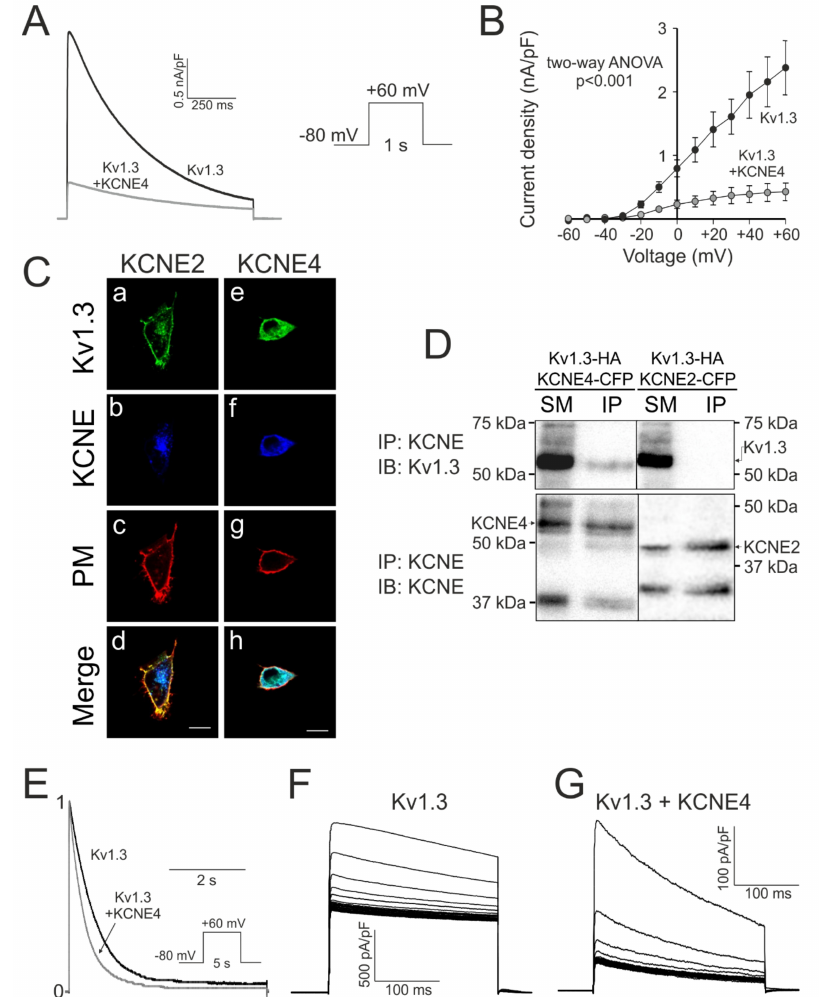
Figure 2. KCNE4 specifically modulates Kv1.3. HEK-293 cells were transfected with Kv1.3-YFP in the presence ( + KCNE4) or the absence of KCNE4-CFP. Cells were held at − 80 mV, and currents were elicited by 1 s depolarizing pulses from − 60 mV to + 60 mV in 10 mV intervals. ( A ) Representative traces at + 60 mV. ( B ) Current density vs. the voltage of K + currents ( p < 0.001 vs. + KCNE4, two-way ANOVA; n = 3–5). Values are the means ± SE. Black symbols, Kv1.3; gray symbols, Kv1.3 + KCNE4. ( C ) Confocal images of HEK-293 cells cotransfected with Kv1.3-YFP and KCNE2-CFP (Ca-Cd) and KCNE4-CFP (Ce-Ch). (a, e) Green, Kv1.3; (b, f) blue, KCNE; (c, g) red, plasma membrane marker (PM); (d, h) merged images. White, triple localization; yellow, double green and red colocalization. ( D ) Coimmunoprecipitation of KCNE4, but not KCNE2, with Kv1.3. HEK-293 cells were cotransfected with Kv1.3-HA and KCNE2-CFP and KCNE4-CFP. Samples were immunoprecipitated (IP) against KCNE (anti-CFP) and immunoblotted (IB) against Kv1.3 (anti-Kv1.3) and KCNE (anti-GFP). SM, starting materials; IP, immunoprecipitates. ( E ) C-type inactivation. Cells expressing Kv1.3 without or with + KCNE4 were held at − 80 mV, and a 5 s depolarizing pulse to + 60 mV was applied. Black, Kv1.3; gray, Kv1.3 + KCNE4. ( F ) Cumulative inactivation of HEK-293 cells transfected with Kv1.3. ( G )